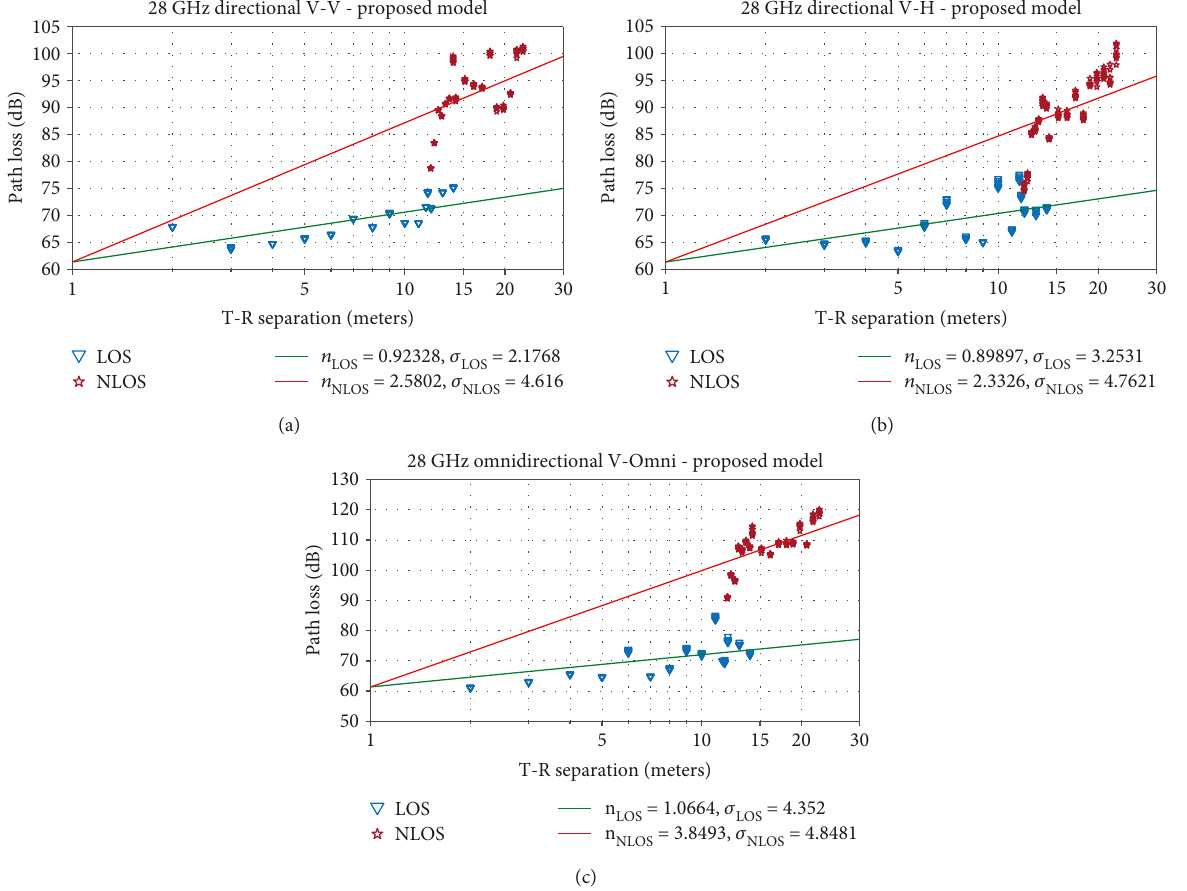
Figure 10: Proposed model for 28 GHz for LOS and NLOS (a) V-V, (b) V-H, and (c) V-Omni antenna